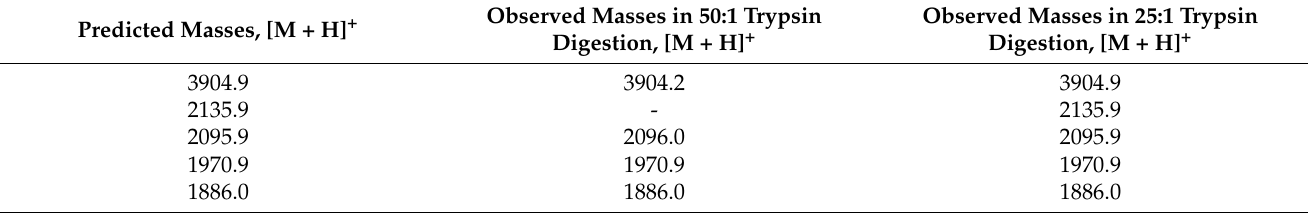
Table 1. The predicted mass fragments and the observed mass fragments for 50:1 and 25:1 recombi- nant iturin A trypsin digestion